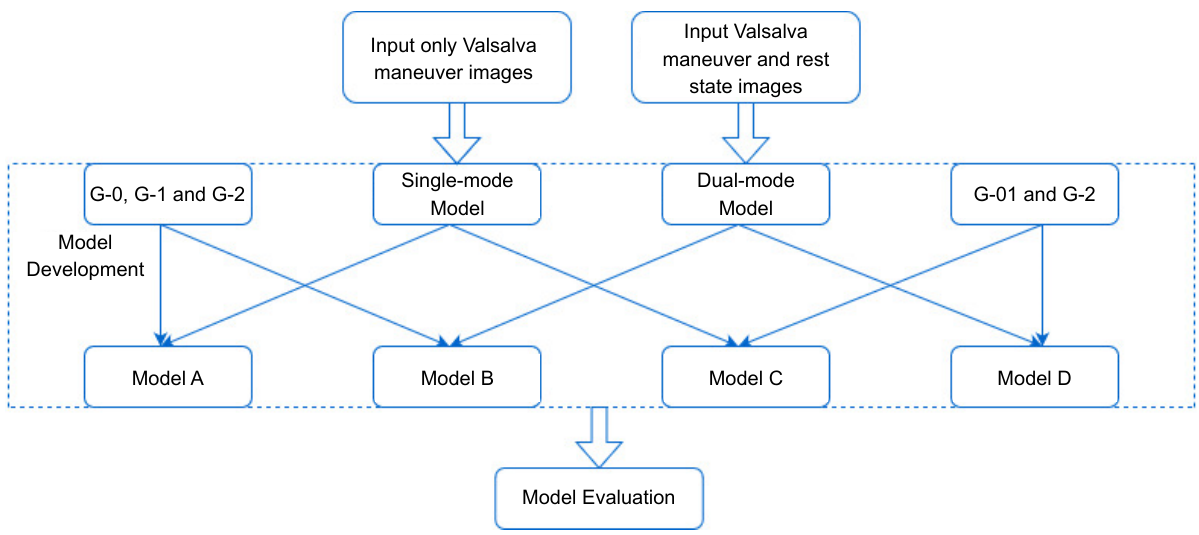
Figure 3A The Flowchart of the processing stages of the AI algorithm.